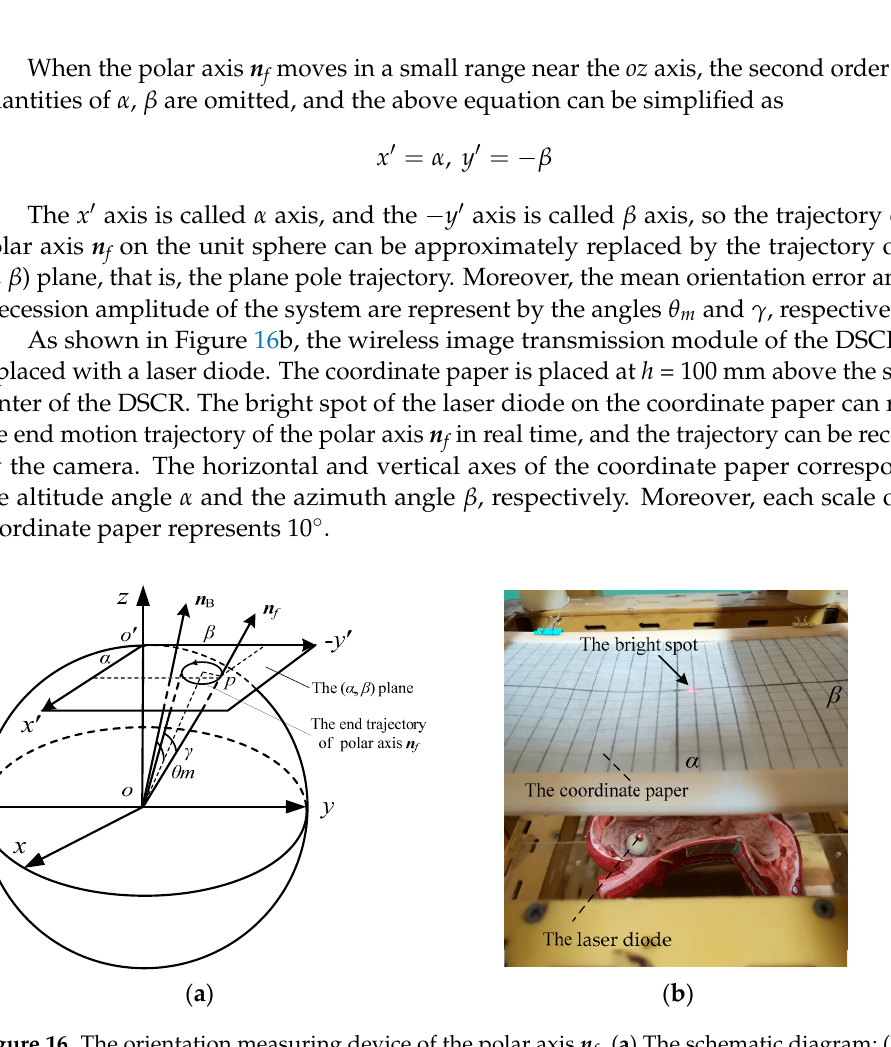
f . ( a ) The schematic diagram; ( b ) The